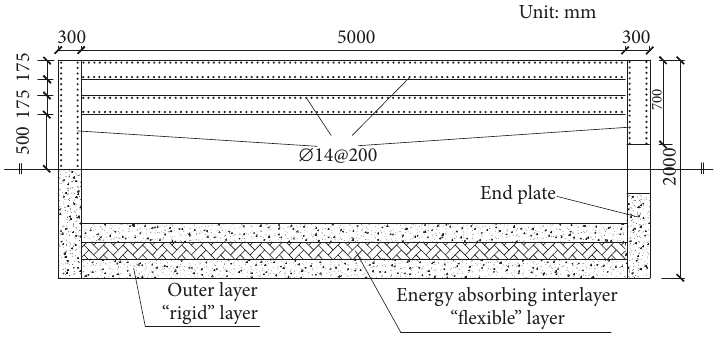
Figure 1: Dimensions diagram of the test model.